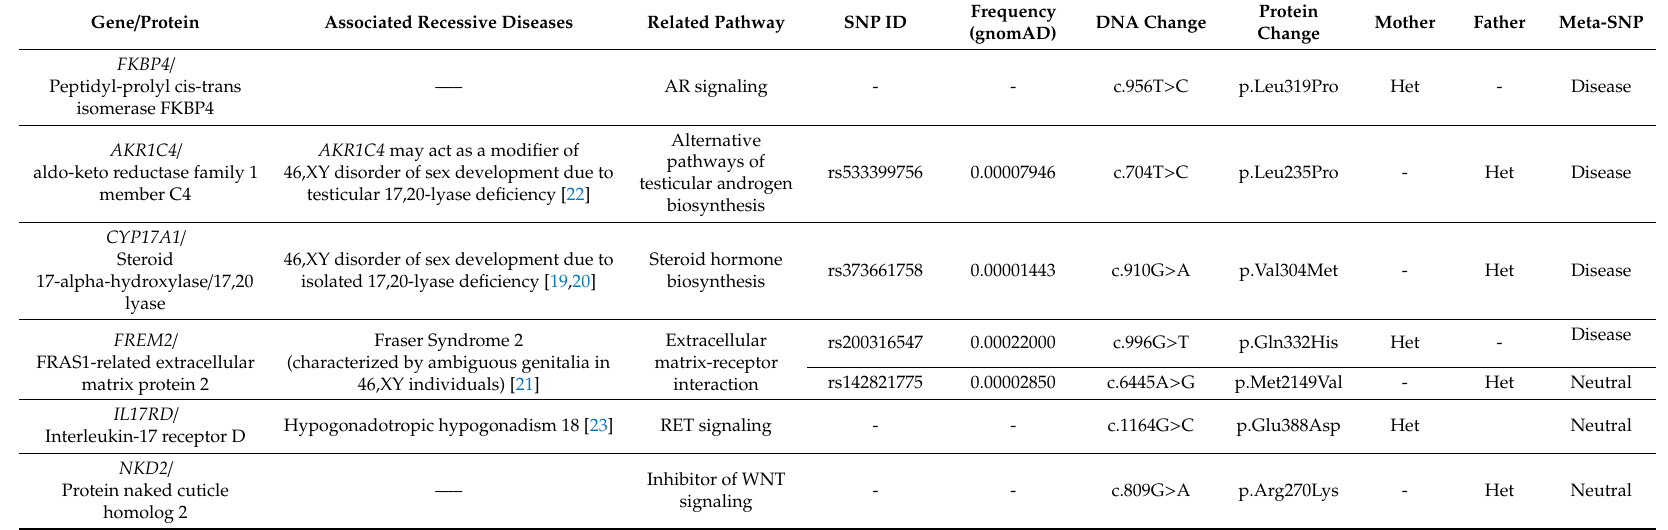
Table 2. List of heterozygous variants in autosomal genes involved in sexual development identified in the partial androgen insensitivity syndrome (PAIS) patient. Gene /